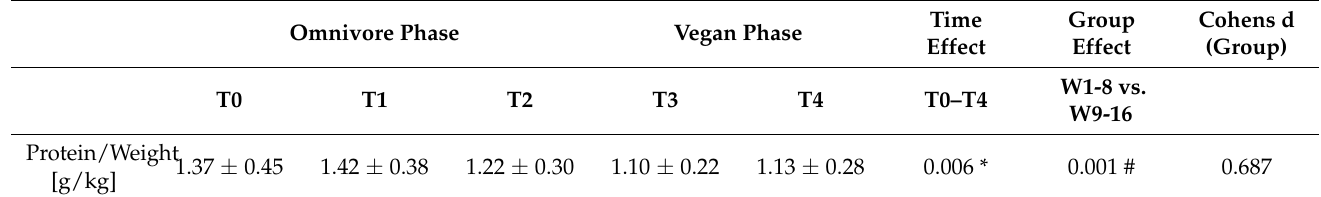
Table 3. Relative protein